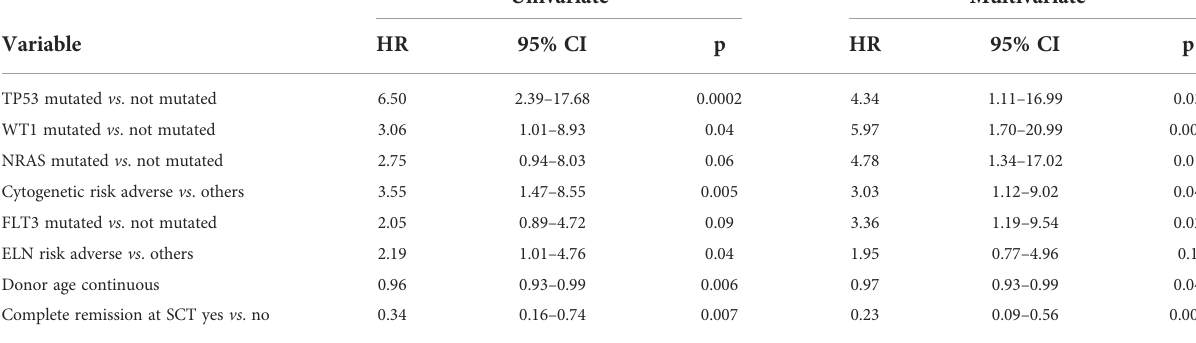
TABLE 3 Cox regression for disease-free